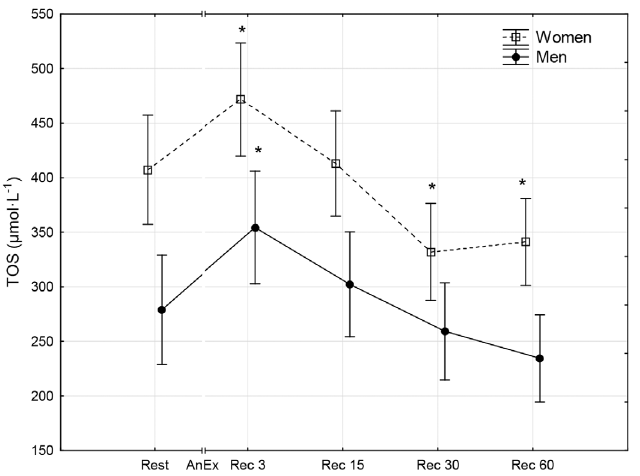
Fig 1. The level of total oxidative status (TOS) prior to (Rest) and 3 minutes (Rec 3), 15 minutes (Rec 15), 30 minutes (Rec 30) and 60 minutes (Rec 60) after anaerobic exercise (AnEx). Data are given as mean ± standard error; * p < 0.05 statistically significant differences between results obtained after anaerobic exercise (AnEx) and initial results